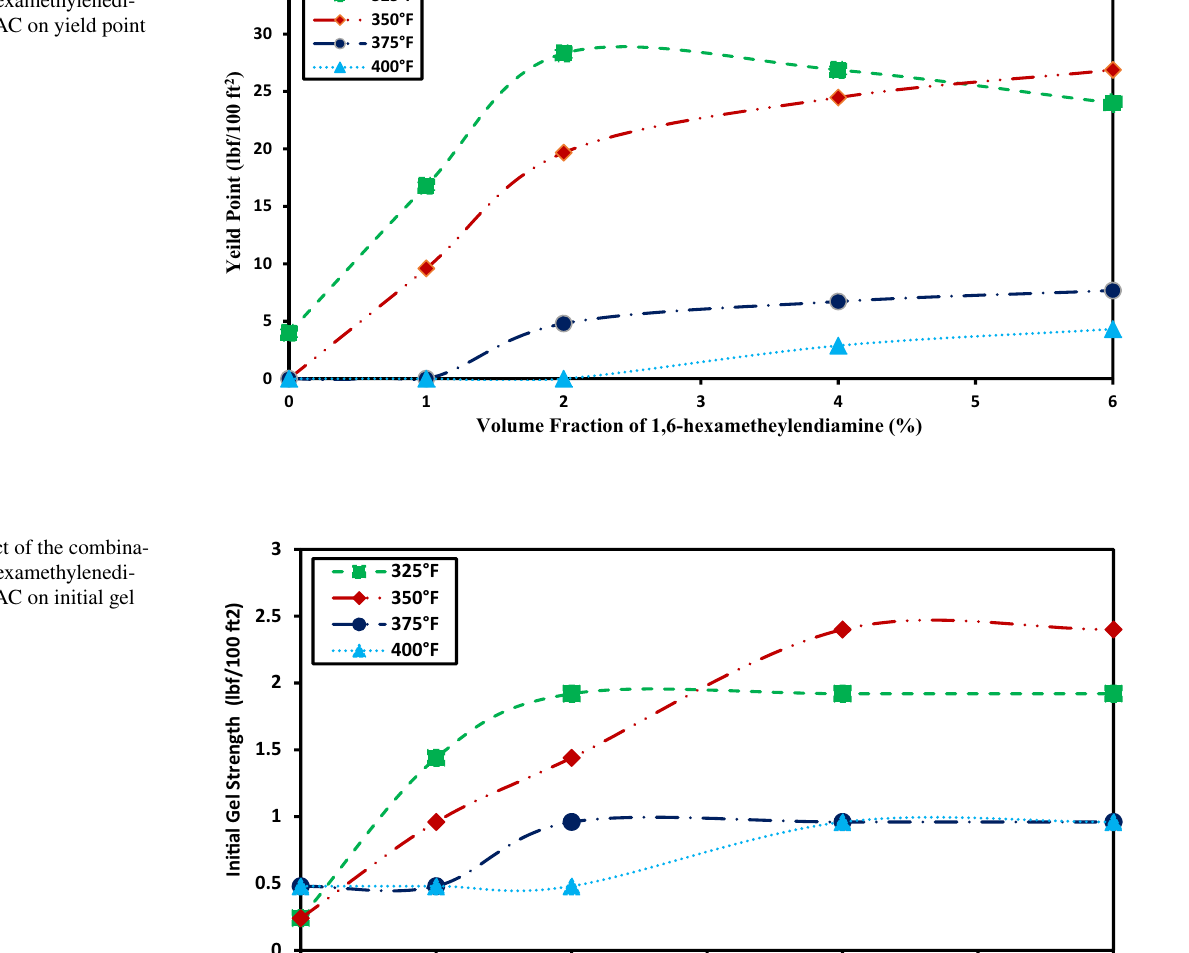
Fig. 10 Effect of the combina- tion of 1,6-hexamethylenedi- amine and PAC on yield point